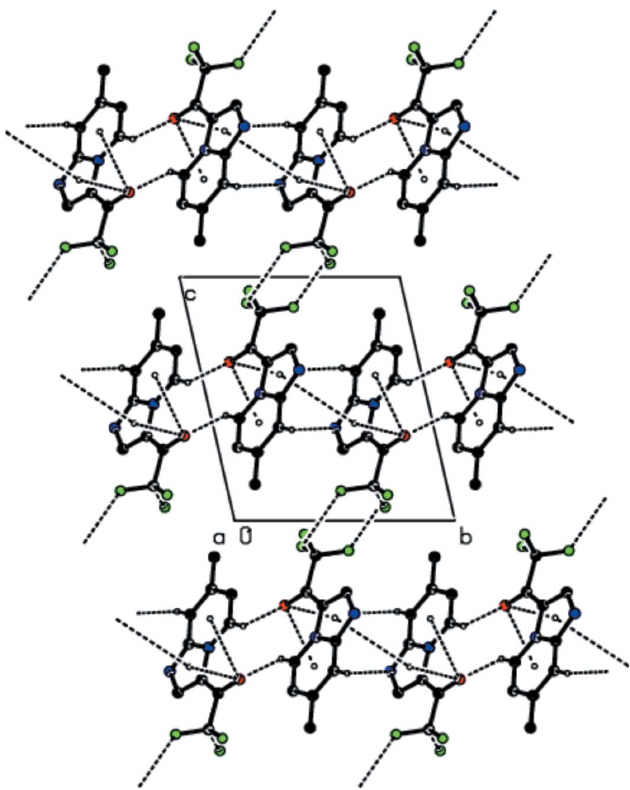
Figure 3 Packing diagram of the title compound, viewed down the a axis showing the C—H (cid:2)(cid:2)(cid:2) O and C—H (cid:2)(cid:2)(cid:2) N hydrogen bonds and the F (cid:2)(cid:2)(cid:2) F and (cid:2) – (cid:2) stacking interactions. Hydrogen atoms not involved in hydrogen bonding are omitted.